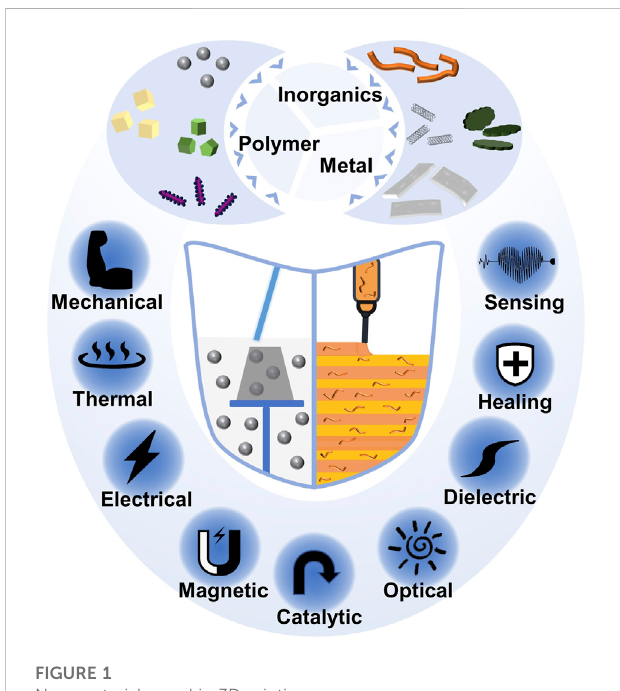
FIGURE 1 Nanomaterials used in 3D printing.